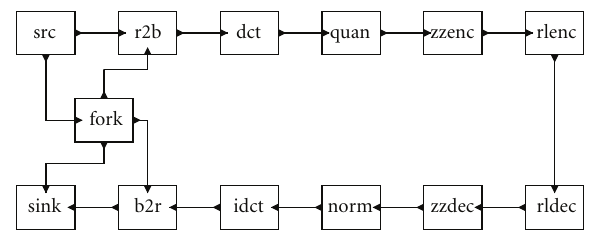
Figure 7: JPEG Encoder & Decoder implemented with SACRE KPN library.